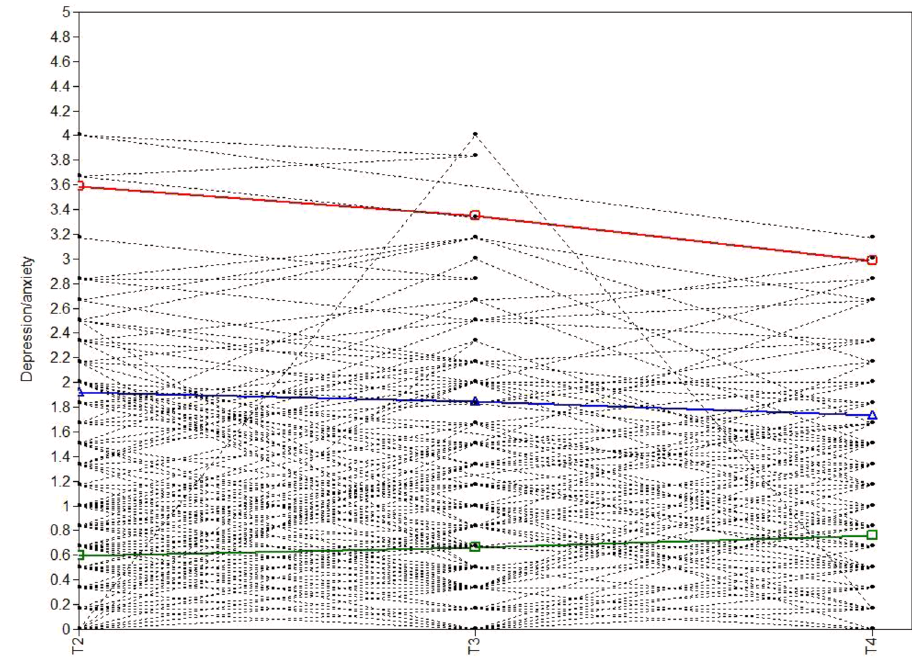
Figure 2. Estimated means and observed individual values during the COVID-19 pandemic for depression and anxiety. Note. The red line is the smallest class ( N = 5, 3%; high-decreasers), the blue line the intermediate class ( N = 53, 30%; moderate-stable) and the green line the largest class ( N = 120, 67%; low-stable).